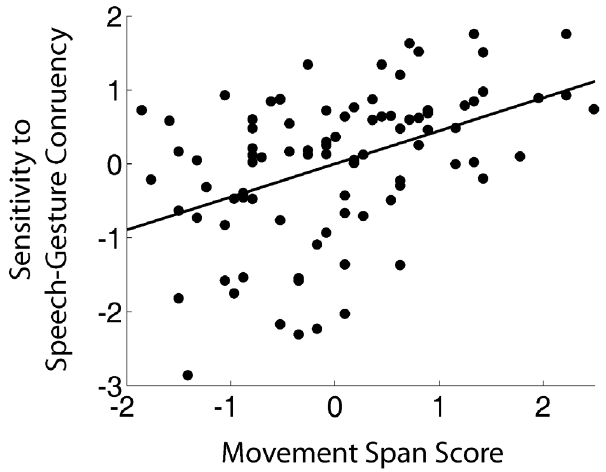
Figure 4. Mean recall accuracy for items at levels three through five with 95% confidence intervals. The y-axis reflects the proportion of participants who correctly reenacted the target movements at each position in the